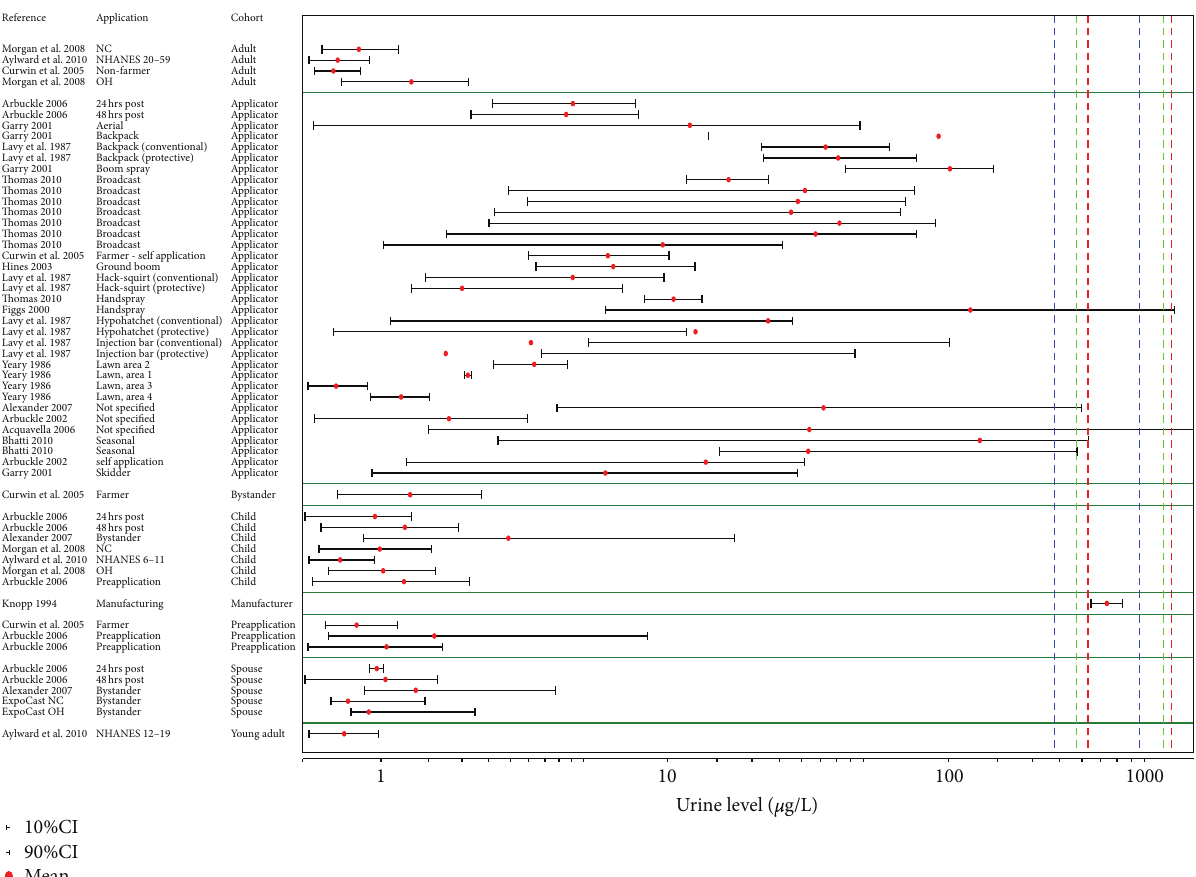
Figure 7: Biomonitoring data for 2,4-D in the context of backcalculated urine levels. Reference lines: green = men 575 𝜇 g/L (RfD), men 1170 𝜇 g/L (ToxCast reverse dosimetry). Blue = women 480 𝜇 g/L (RfD), women 960 𝜇 g/L (ToxCast reverse dosimetry). Red = child 630 𝜇 g/L (RfD), child 1250 𝜇 g/L (ToxCast reverse dosimetry) (see for review [26, 124, 154, 201, 214, 215,